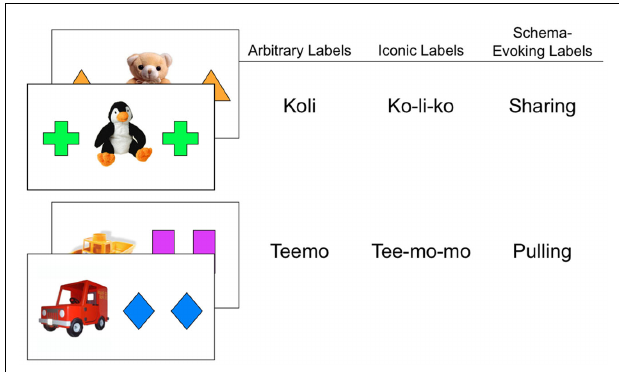
FIGURE 1 | Named instances ofABA and BAA shown to children during